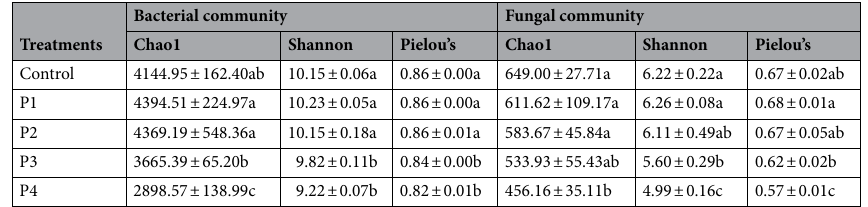
Table 2. Effect of PG on the alpha diversity of soil bacteria and fungal communities. Different lowercase letters represent significant differences at the level of P < 0.05.